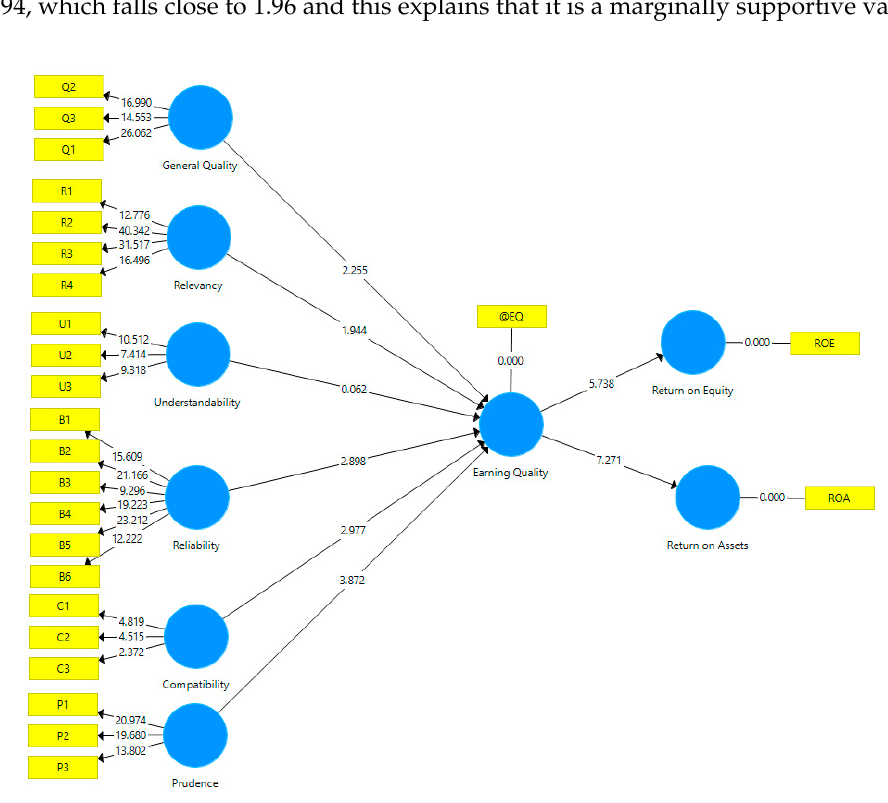
Figure 3. Research Model with Outer Loads and Beta. Source: Developed by the author based on software results.